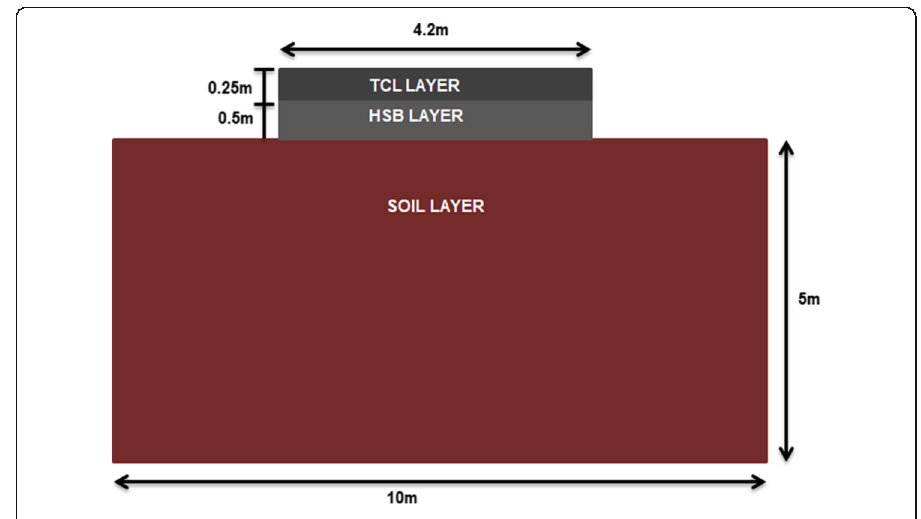
Fig. 9 Cross-section dimensions of the slab track model